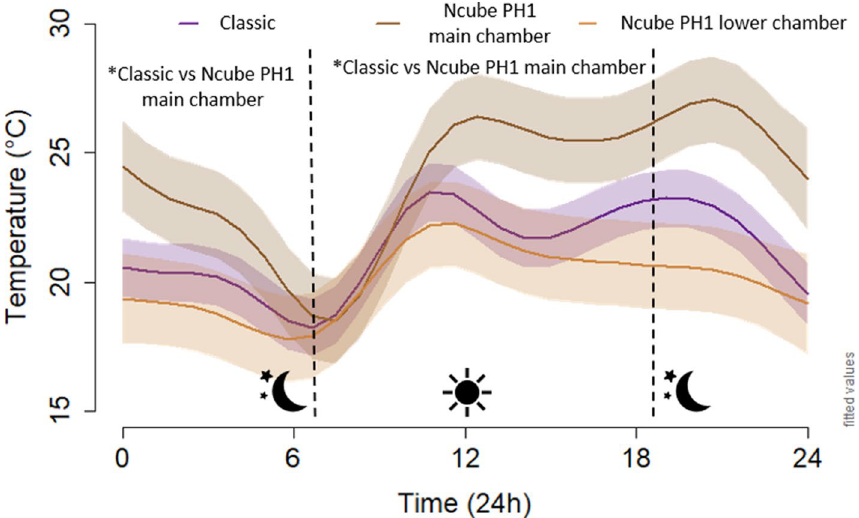
Figure 3. Estimated hourly patterns for the Classic (n = 11) and the Ncube PH1 models (main and lower chambers, n = 8). The estimated values are based on a generalized additive mixed model accounting for time, week, year, structure, external temperature, site, and individual bat box identity. Values of fixed factors have been set to: week = first half of July, year = 2019, structure = building, external temperature = 18 °C. The asterisks (*) represent significant differences between models during the day and night.